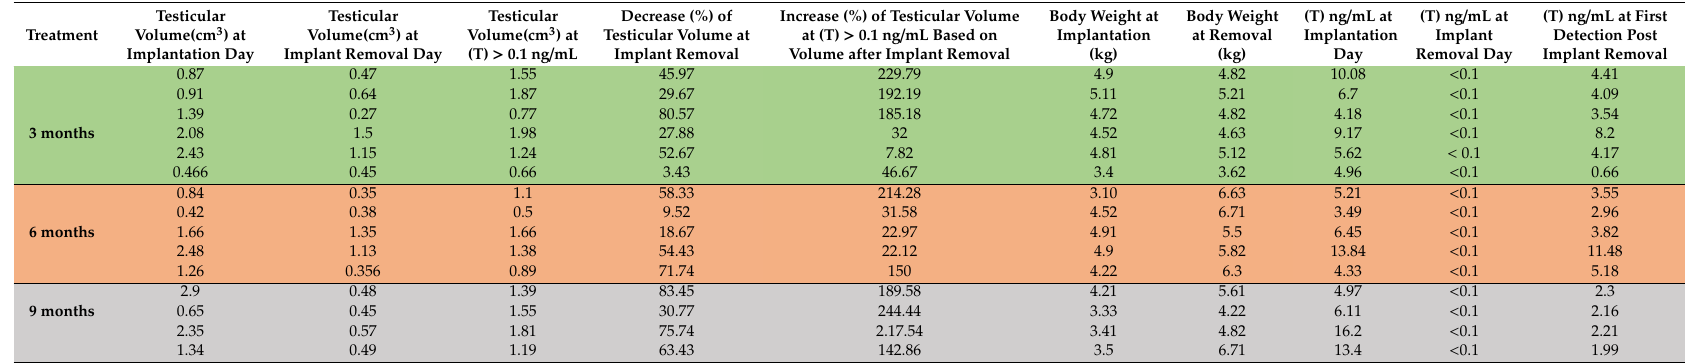
Table 2. Mean testicular volumes (cm 3 ) and serum testosterone concentration (ng / mL) in cats treated with a 4.7 mg deslorelin implant at the beginning of the treatment, on the day of implant removal after 3 (green), 6 (orange), and 9 months (grey), on the day of first testosterone rise detection ( > 0.1 ng / mL), following implant removal and body weights (kg) on the implantation day and day of implant